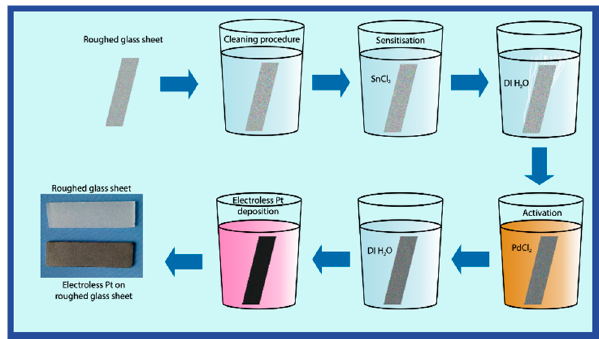
Figure 1. Scheme of electroless platinum deposition.